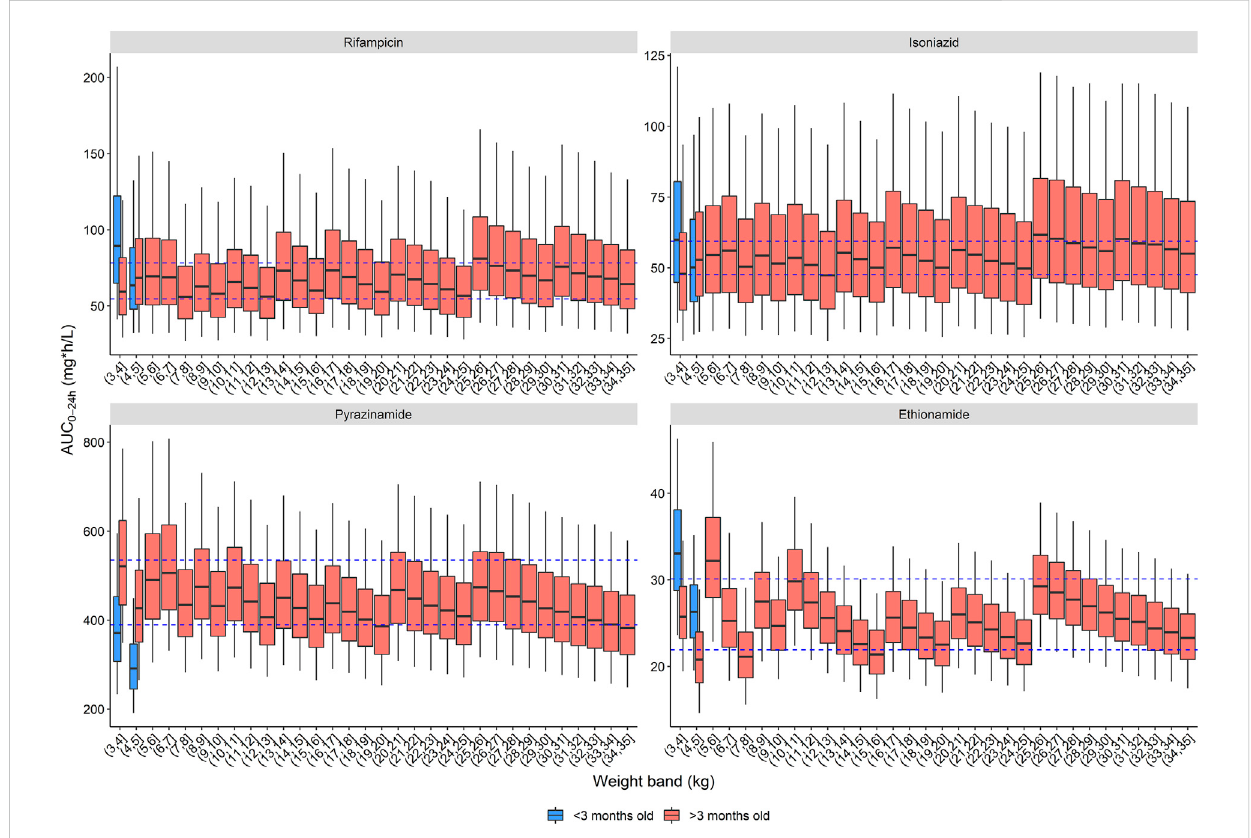
FIGURE 2 Area under the concentration-time curve over a 24-h dose interval (AUC 0 – 24h ) after the WHO recommended dose for children with child-friendly formulations. The box represents the median and 25 th and 75 th percentile. The whiskers represent the 5 th and 95 th percentile. The dashed blue lines represent the target